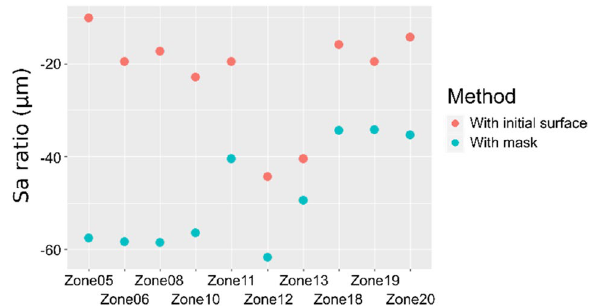
Figure 8. Comparison of Sa ratios computed with access to the initial surfaces versus with the proposed methodology using